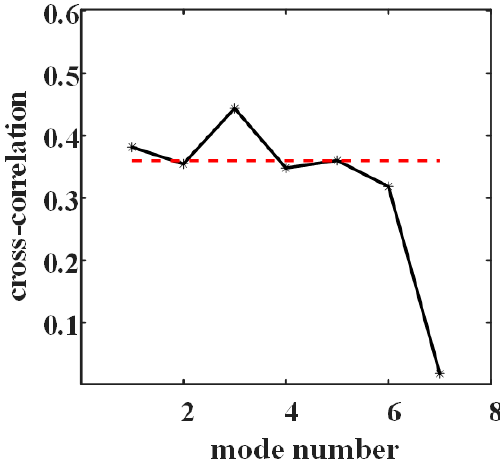
Figure 6. IMF selection with the cross-correlation threshold.